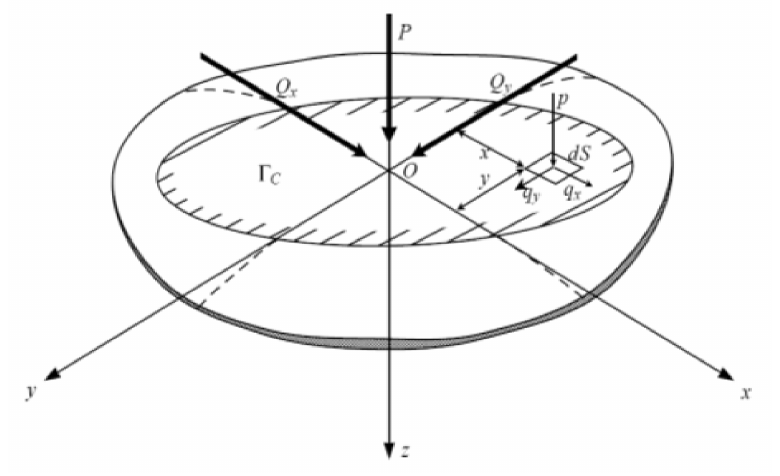
Figure 3. Contact